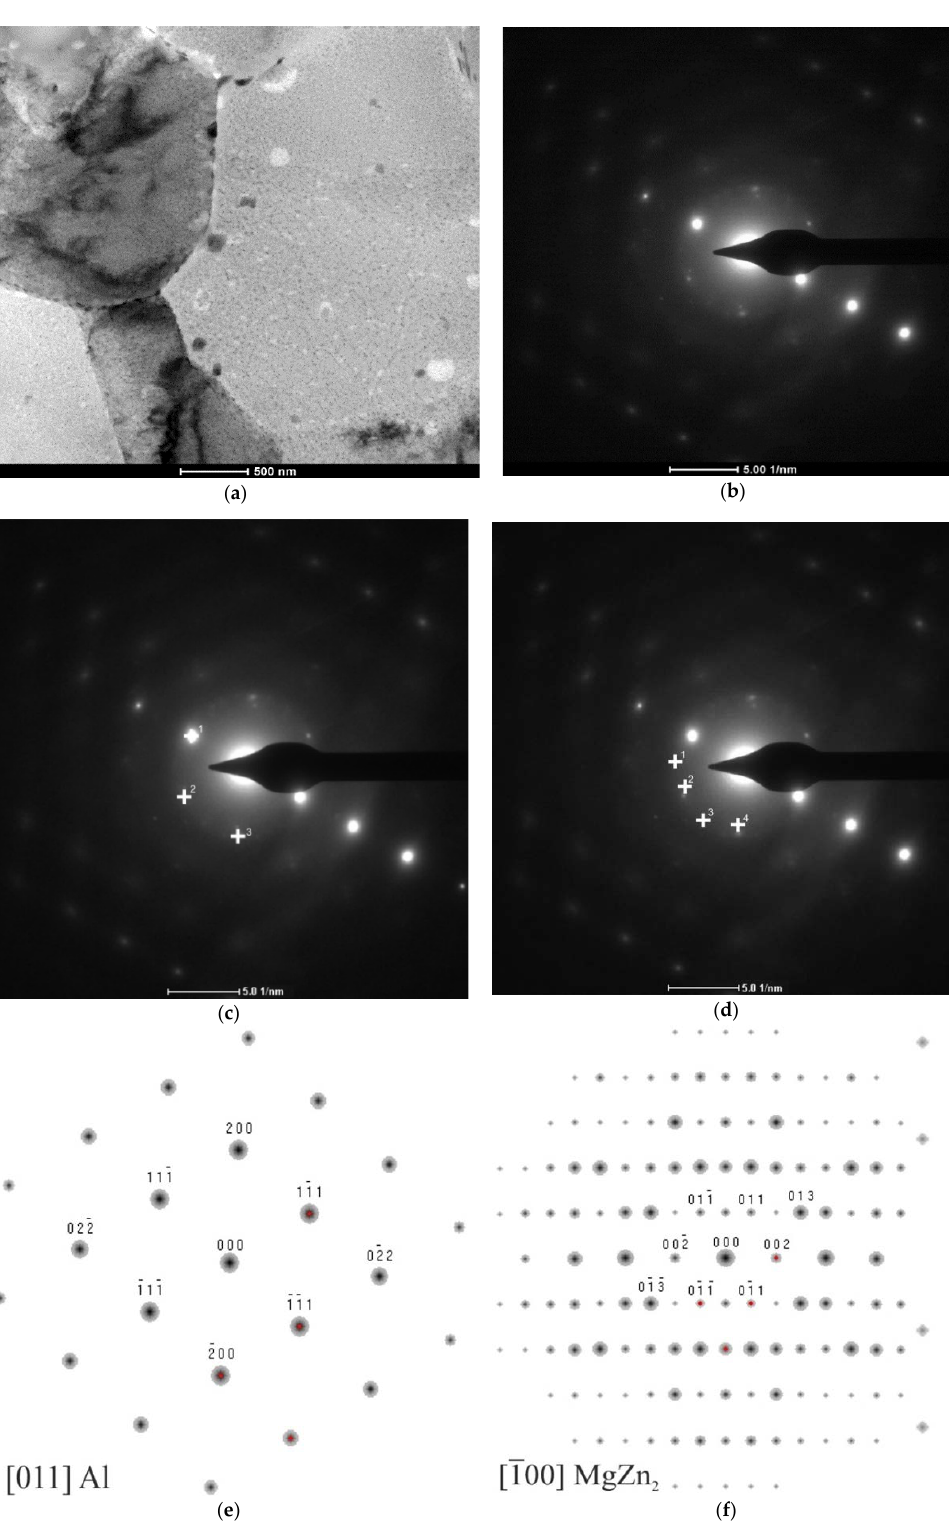
Figure 6. ( a ) Individual secondary precipitates inside the substructure of the 7003 alloy ; ( b ) Electron diffraction; ( c ) Marked reflections of the α solution matrix ; ( d ) Marked reflections of the MgZn 2 particle; ( e ) A solution of α phase matrix diffraction and ( f ) a solution of MgZn 2 phase diffraction.